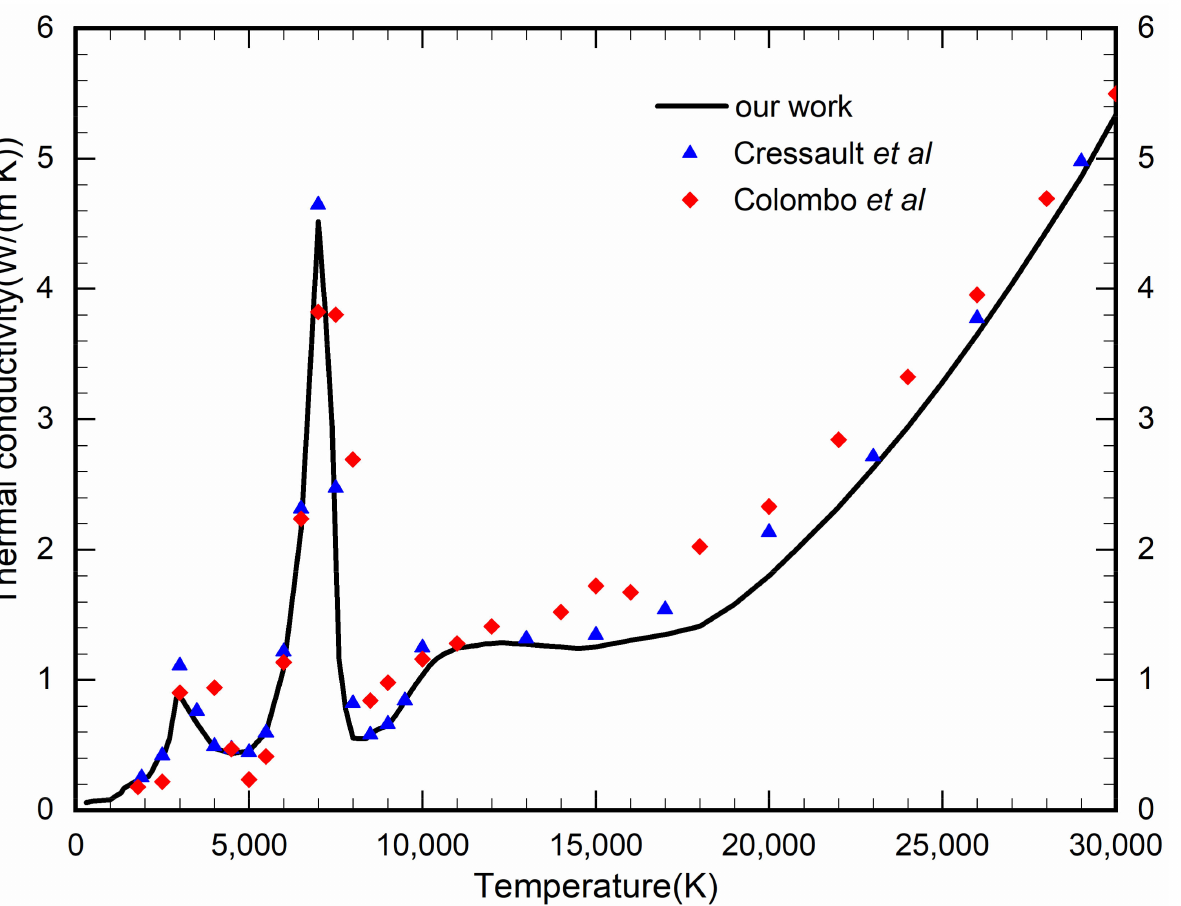
Figure 10. The thermal conductivity of pure CO 2 at 0.1 MPa. The calculated results are shown for